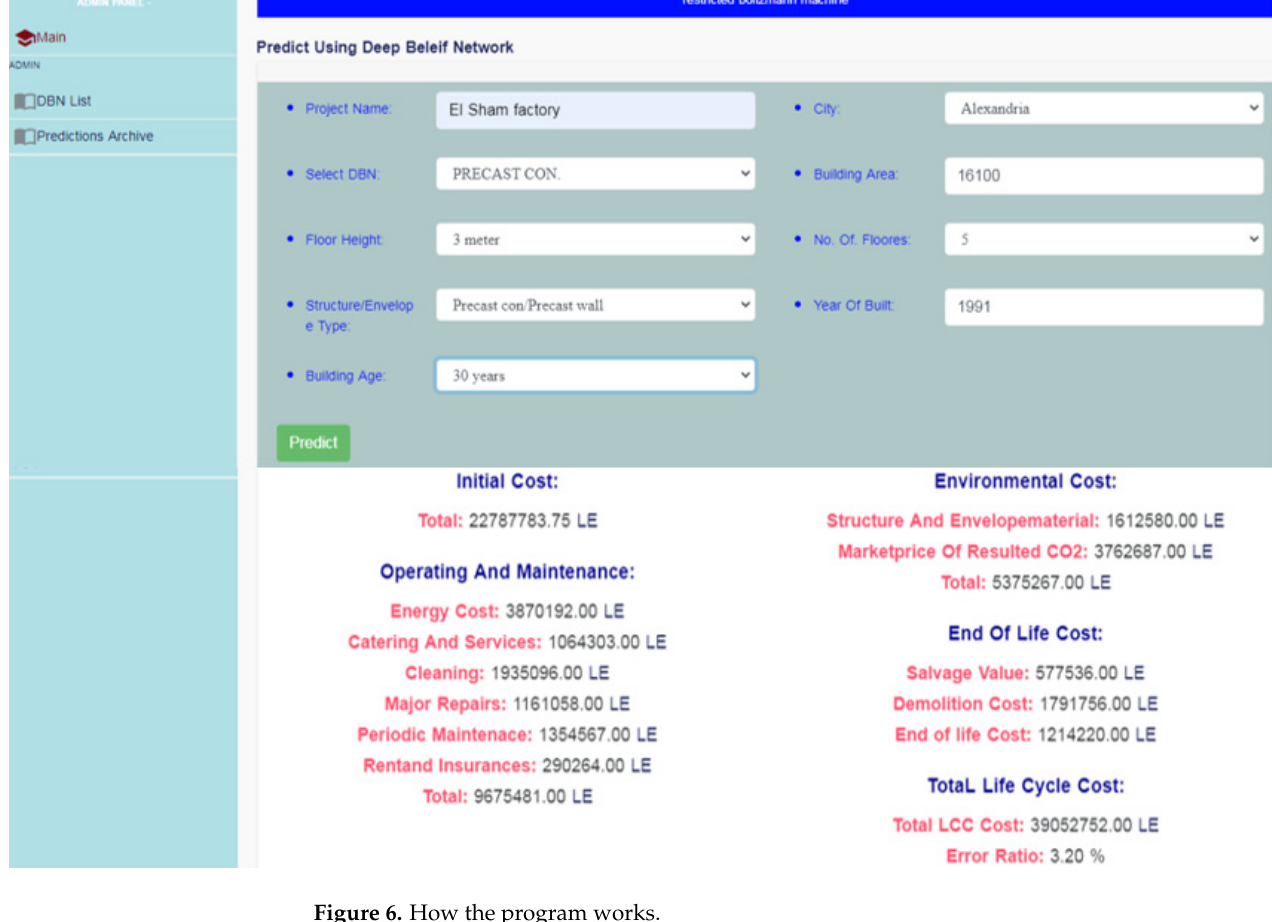
Figure 6. How the program works.